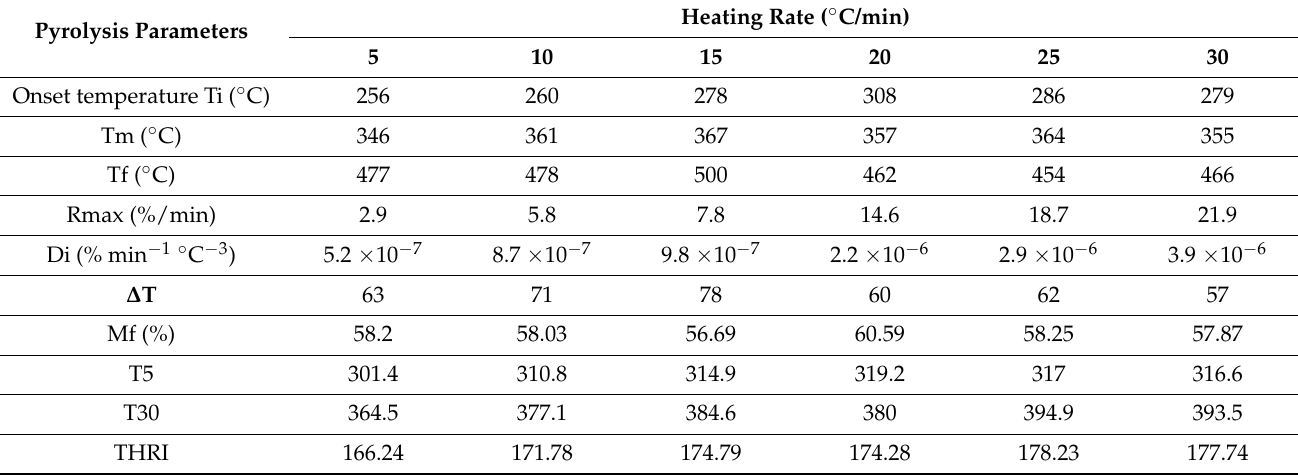
Table 3. The pyrolysis characteristic parameters for GFRC at different heating